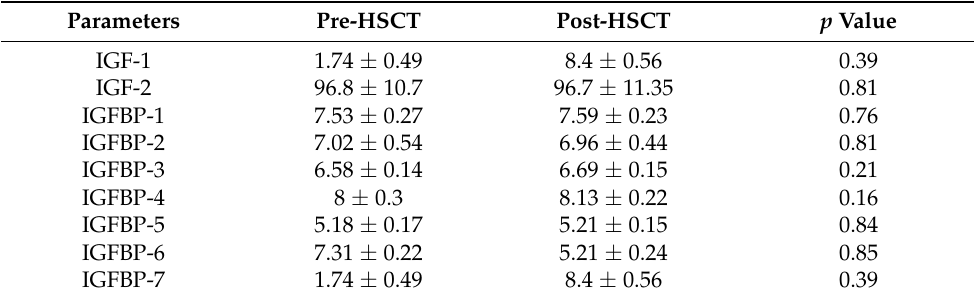
Table 7. Gene expression differences between the pre-HSCT and post-HSCT group (log2 mean ± standard deviation), representing the recorded signal intensity of the